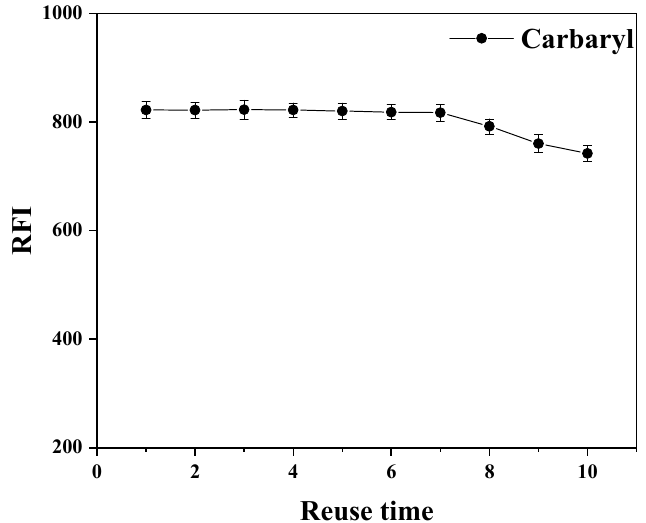
Figure 3. Reusability of the magnetic COF (TpPa-NH 2 )@Fe 3 O 4 (5 mg COF (TpPa-NH 2 )@Fe 3 O 4 , 50 mL of sample solution; c = 100 ng·mL − 1 ; extraction time: 5 min; 0.4 mL acetonitrile as desorption solvent was vortexed for 6 min, n = 3).